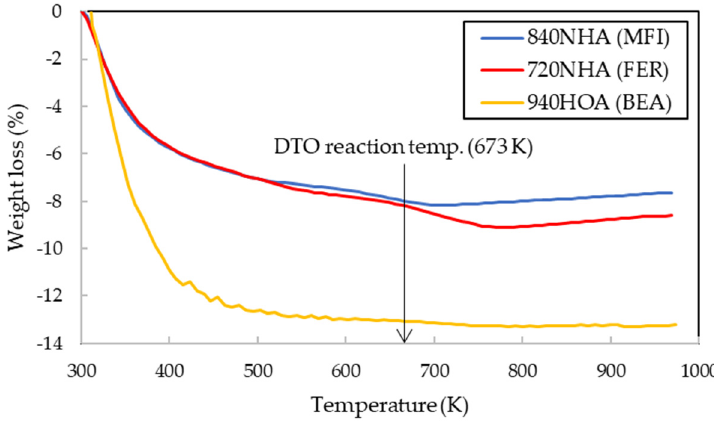
Figure 2. Dependence of weight loss on temperature by TG analysis. For all three types of zeolites, with an increase in temperature to approximately 400 K, a drastic weight loss was observed due to the desorption of physically adsorbed H 2 O molecules. Thereafter, the weights of 840NHA (MFI) and 720NHA (FER) decreased slowly because of the desorption of NH 3 molecules, as well as dehydration, reaching their minimum values at approximately 700 K and 780 K, respectively, and then increased again with increasing temperatures. In contrast, the weight of 940HOA (BER) decreased monotonically, remaining almost constant above 760 Table 2. Catalytic performance in DTO reaction using zeolites at different calcination temperatures. Calcination Material Topology Temp. (K) BEA